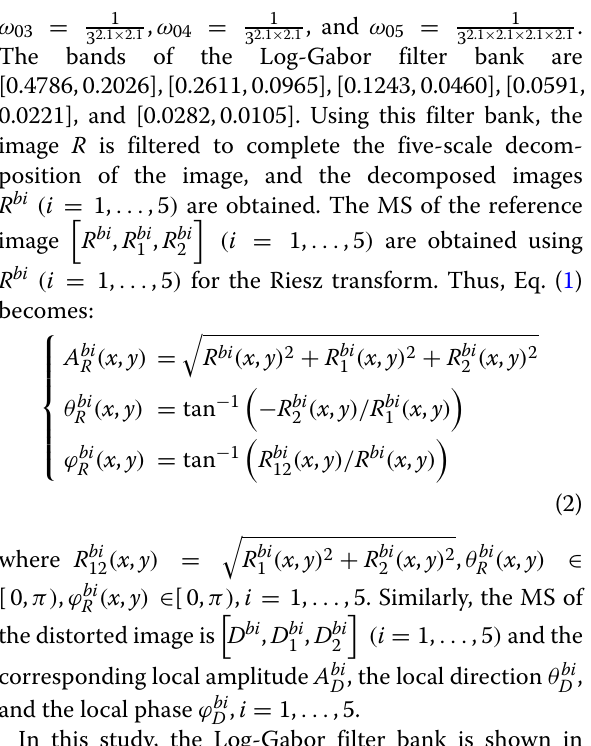
and the local phase ϕ bi